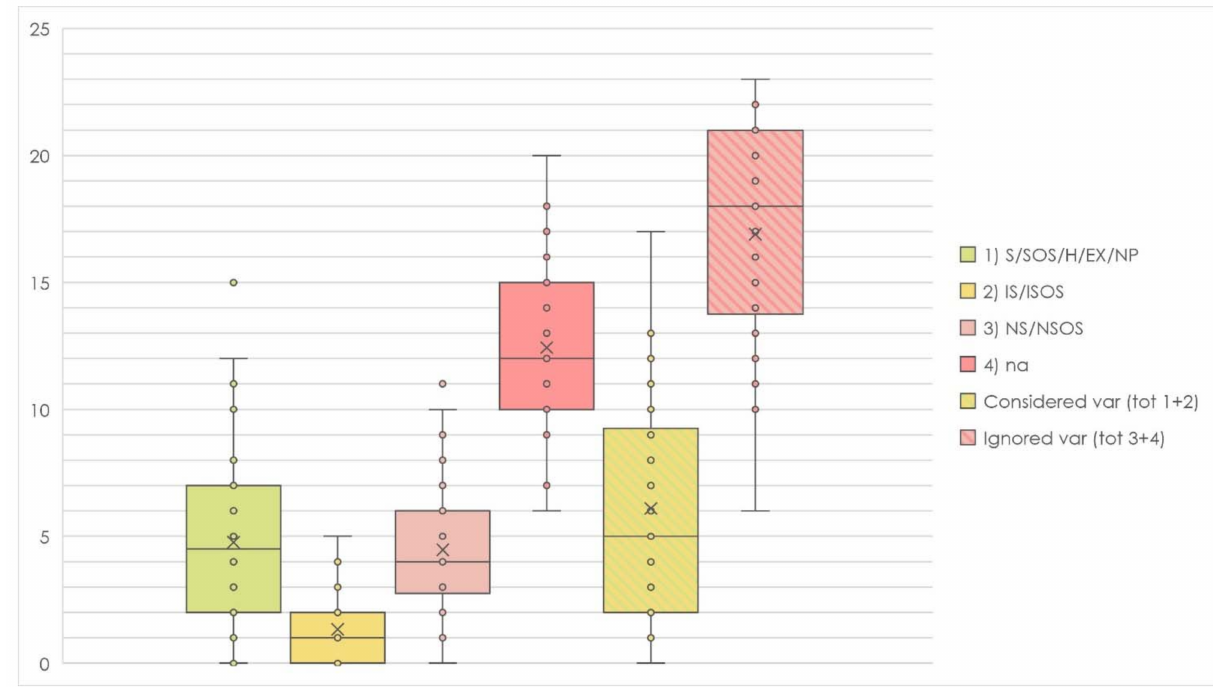
Figure 5. Box plot representation of the considered independent variables during data analysis and cohort selection. Legend to Figure 5: Ex = excluded; H = homogeneous; IS = incomplete/inadequate stratification; ISOS = incomplete/inadequate stratification by oral subsites; na = not available; nc = not clear; NP = not present; NS = not stratified; NSOS = not stratified by oral subsites; S = stratified; SOS = stratified by oral